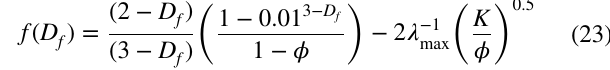
Table 2 Deviations of fractal dimensions from calculated fractal in the present